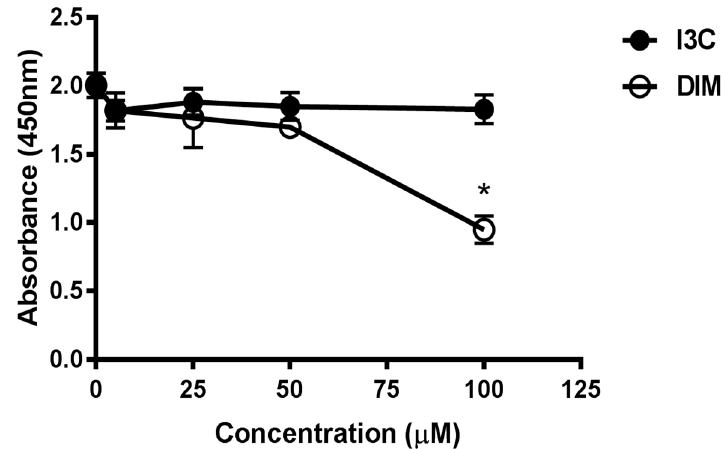
Figure 1. Assessment of cell viability following treatment with different doses of Indole-3-Carbinol (I3C) and Dimer Diindolylmethane (DIM) in Jurkat cells. Jurkat cells were plated at a density of 4 × 10 − 5 cells/mL in a 96 well plate overnight. Cells were treated with varying doses of I3C or DIM for 48 h and cell viability was assessed using CCK8 kit following manufacturer’s instructions. Results expressed as mean ± SD ( n = 3) from three independent experiments. * indicates significantly different compared to control (0.1% dimethyl sulfoxide (DMSO) at p < 0.05 (One-Way Anova).